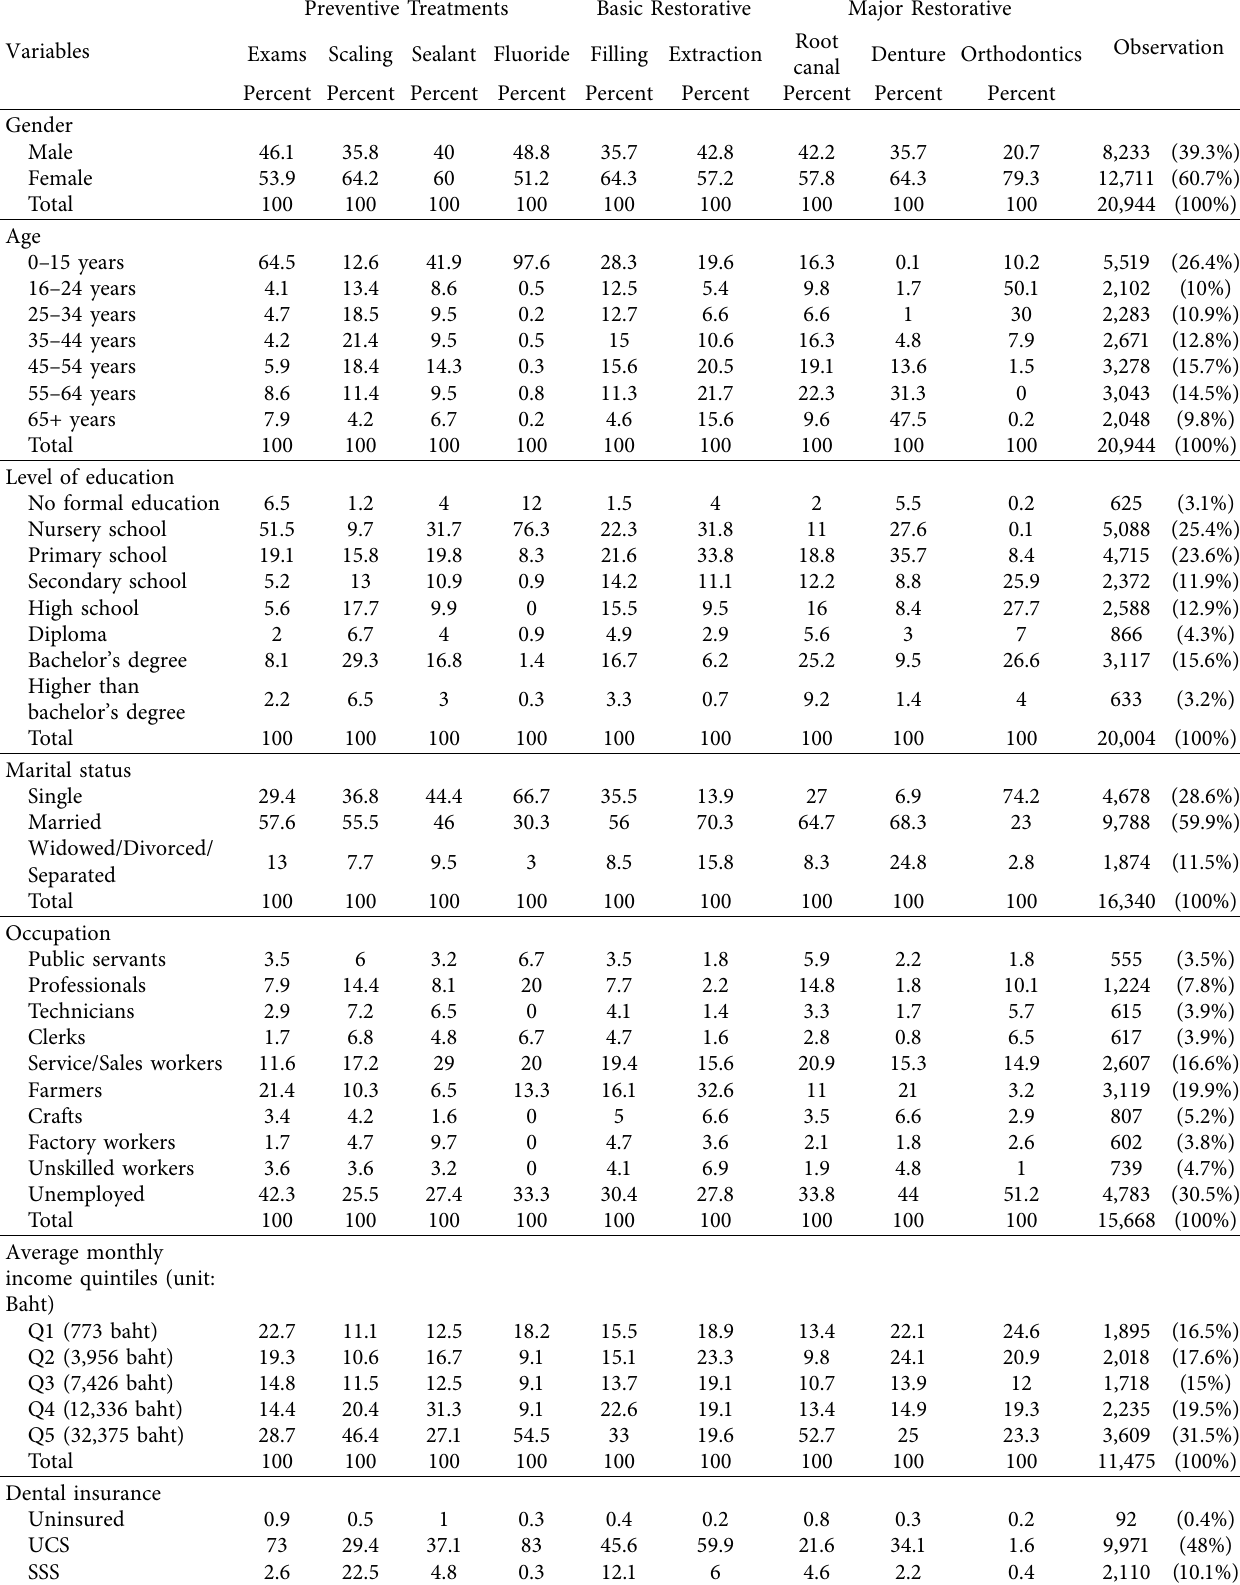
Table 3: Use of dental treatments in the previous 12 Months with socioeconomic characteristics and dental insurance by tabulation. Preventive Treatments Basic Variables